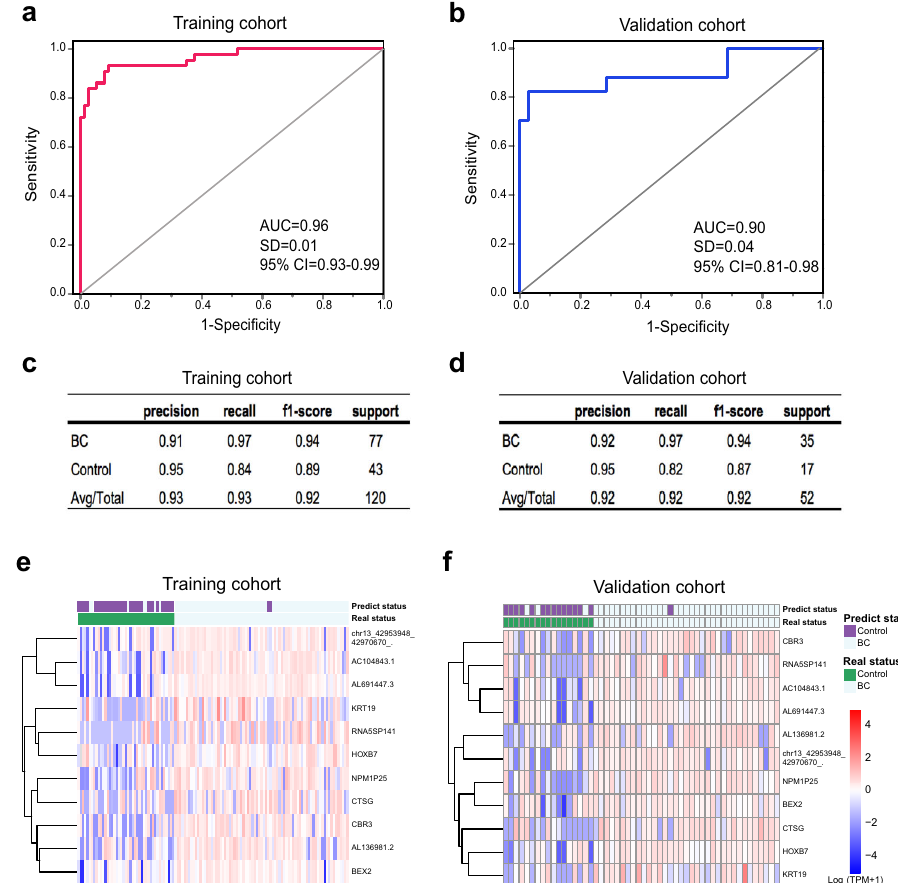
Fig. 3 Blood exLR pro fi les can distinguish BC patients from controls. a , b ROC for the performance of the exLR d-signature in the training ( n = 120, a ) and validation ( n = 52, b ) cohorts. c , d The diagnosis effects of the d-signature in the training ( c ) and validation ( d ) cohorts. e , f Unsupervised hierarchical clustering of eleven exLRs selected for use in the d-signature in the training ( e ) and validation ( f ) cohorts. Each column represents an individual sample, and each row represents an exLR. The scale represents the expression values. ROC receiver operating characteristic, AUC area under the curve, SD standard deviation, CI con fi dence